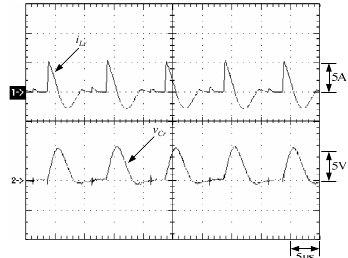
Figure 29. Waveforms pertaining to S 2 , L 2 and L r at the rated load: (1) v S 2 ; (2) i L 2 ; and (3) i Lr .